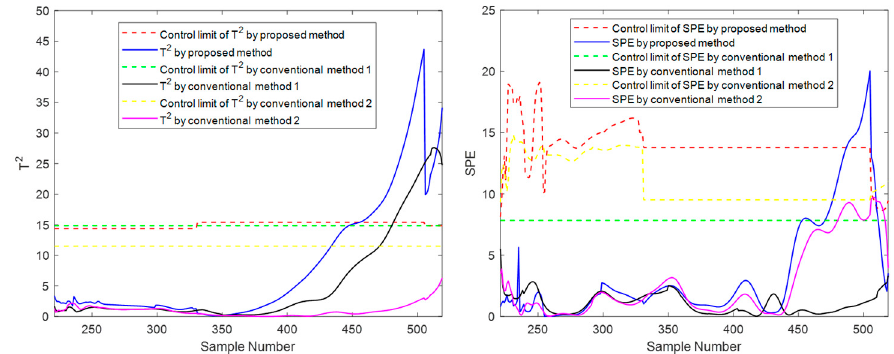
Figure 16. Online monitoring and fault diagnosis of batch 41 after introducing the fault.